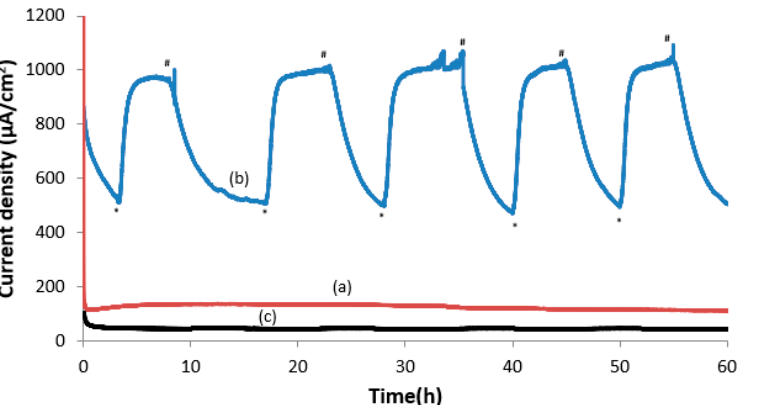
Figure 2. Electro-catalytic performance in oxygen generation from water over 1 h of operation, with and without light illumination (0.25 sun), of FTO glass slide electrodes coated with ( a ) bare Pt (control); ( b ) Pt that was subsequently coated with PEDOT/nano Co 3 O 4/ rGO, where the polymerization mixture used to fabricate the nanocomposite contained 110 mg of nano Co 3 O 4 and 2.0 mg of rGO; and ( c ) PEDOT only (control). Conditions: applied bias on the electrodes of 0.80 V (vs Ag/AgCl) in 0.2 M Na 2 SO 4 (pH 12) (* = ’light on’, # = ’light off’).